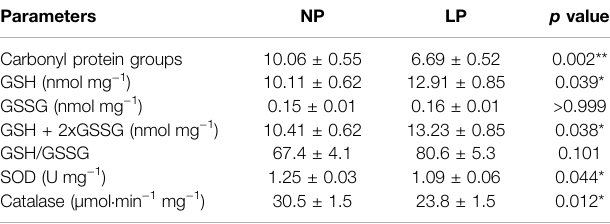
TABLE 5 | Oxidative stress in brainstem. Parameters